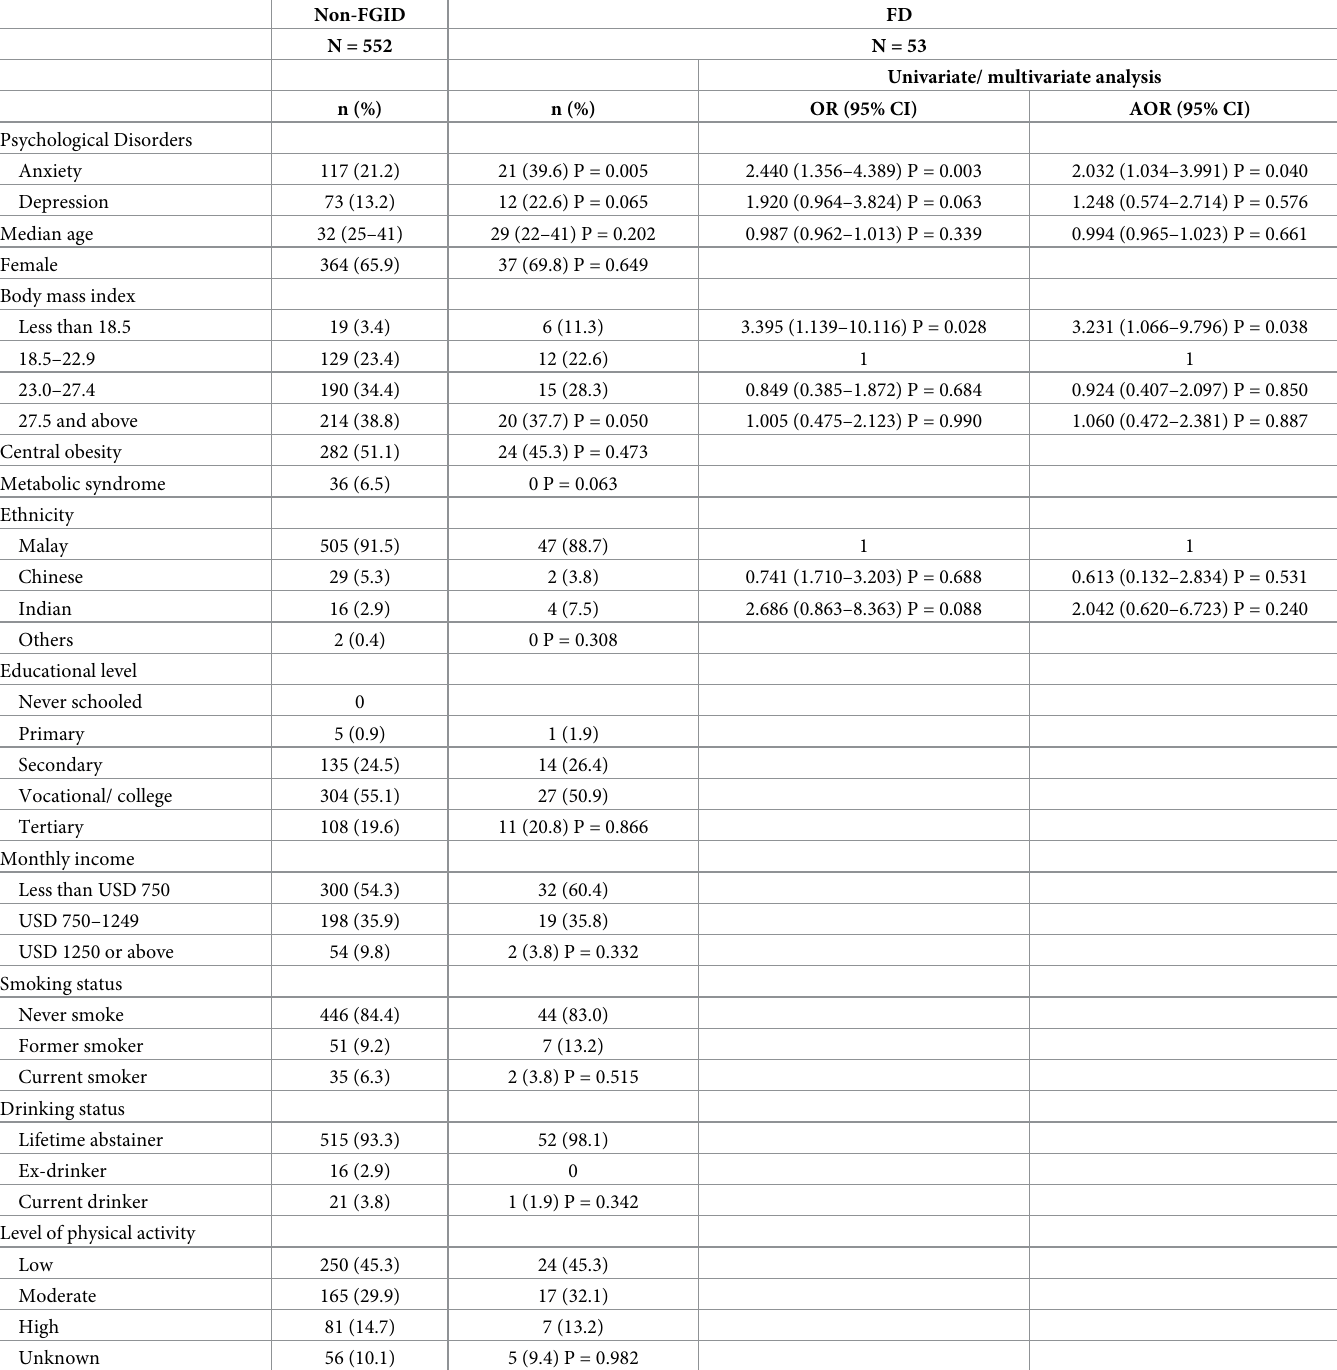
Table 3. Univariate and multivariate analysis of risk factors for FD with psychological disorders (N = 605). Non-FGID FD N = 552 N = 53 Univariate/ multivariate